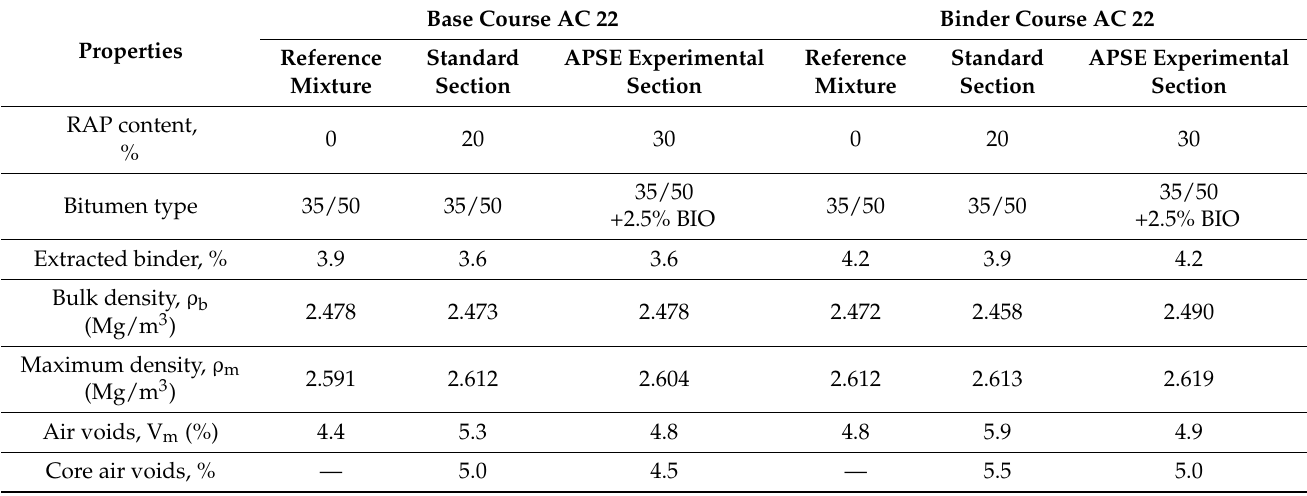
Table 1. Composition and properties of base and binder courses